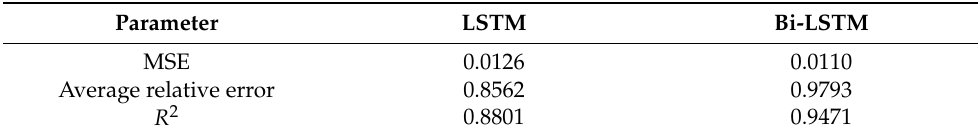
Figure 9. Plots of Bi-LSTM and LSTM predicted values fitted to the true values. Table 3. Comparison of the results of different